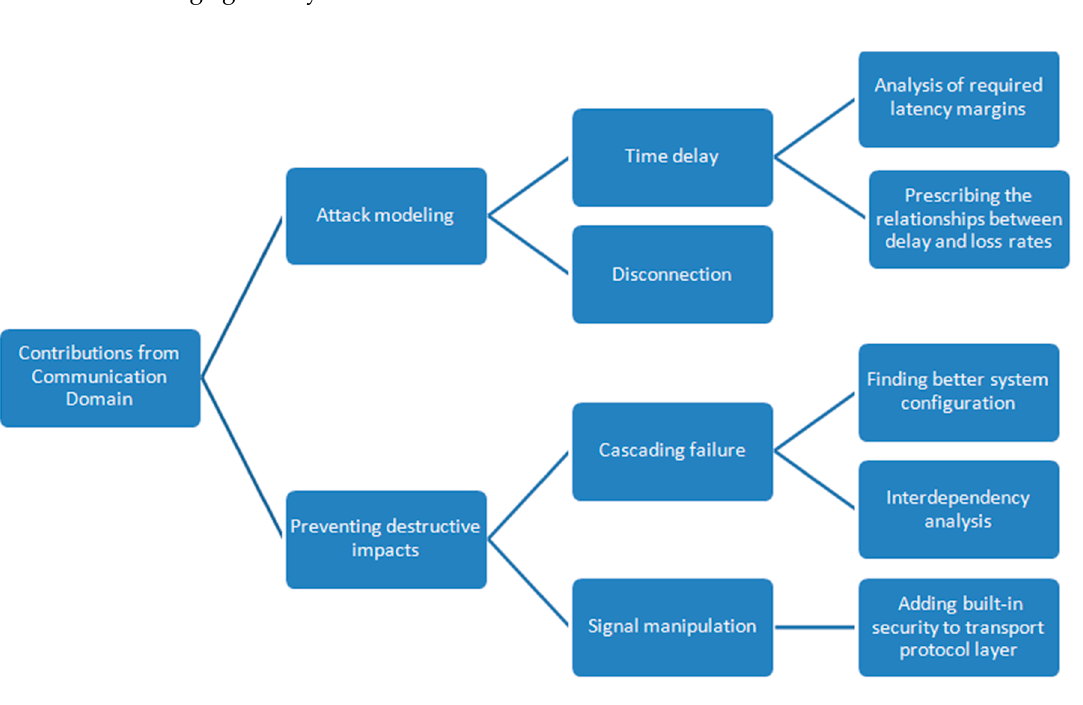
Figure 4. Contributions from the communication domain.